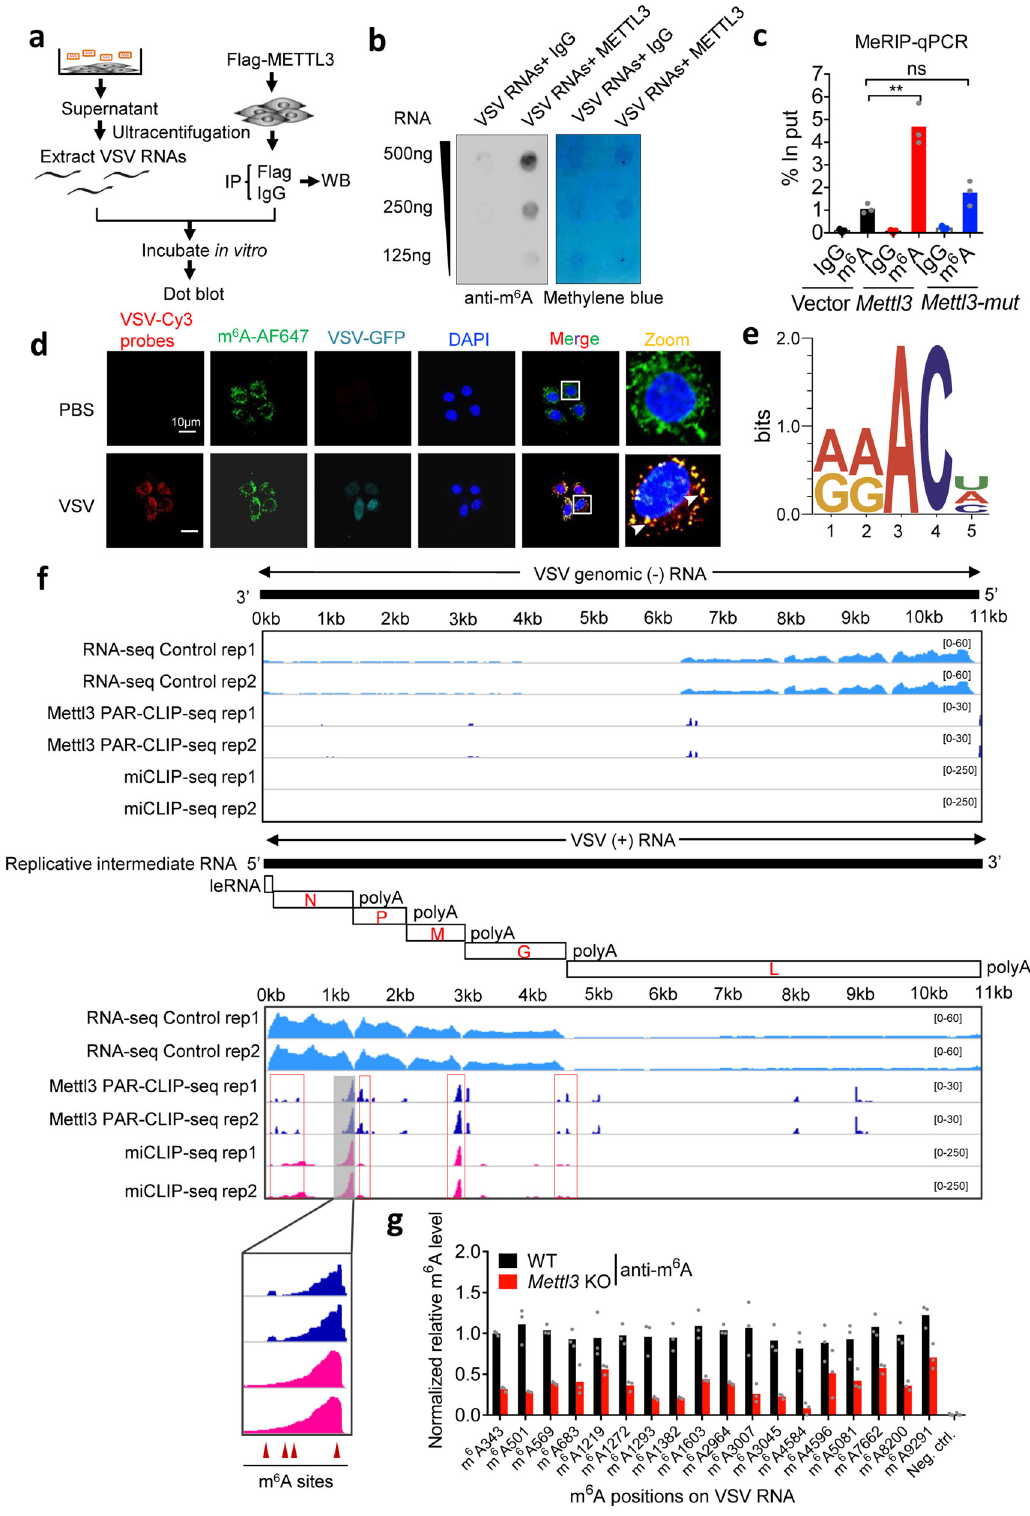
Fig. 4 METTL3 mediates m 6 A modi fi cation on VSV RNA. a A schematic representation of the experimental procedure used in b . b Dot blot analysis of VSV RNA m 6 A level treated with immunoprecipitated (IP)-IgG or IP-METTL3, respectively. Methylene blue staining indicated the loading control. c MeRIP- qPCR analysis of VSV RNA m 6 A level following treatment with overexpression of WT or Mettl3-mut, respectively. n = 2 biologically independent experiments. d RNA-FISH analysis of the co-localization of VSV RNA and m 6 A modi fi cation in the cytosol. e The conserved sequence motif of m 6 A residues in CIMS-based miCLIP-seq. f Integrative genomics viewer (IGV) plots of the METTL3-binding regions and m 6 A modi fi cation on VSV negative sense ( − ) genomic RNA (Upper graph) and VSV positive sense ( + ) RNAs (Lower graph). m 6 A sites are indicated by red triangles. g MeRIP-qPCR analysis of speci fi c m 6 A sites on VSV RNA in WT or Mettl3 KO RAW264.7 cells. n = 2 biologically independent experiments. * p < 0.05, ** p < 0.01, as determined by two-tailed unpaired Student ’ s t test ( c , g ). Error bars represent mean ± SEM. NATURE COMMUNICATIONS| (2021) 12:1582 |https://doi.org/10.1038/s41467-021-21904-y|www.nature.com/naturecommunications